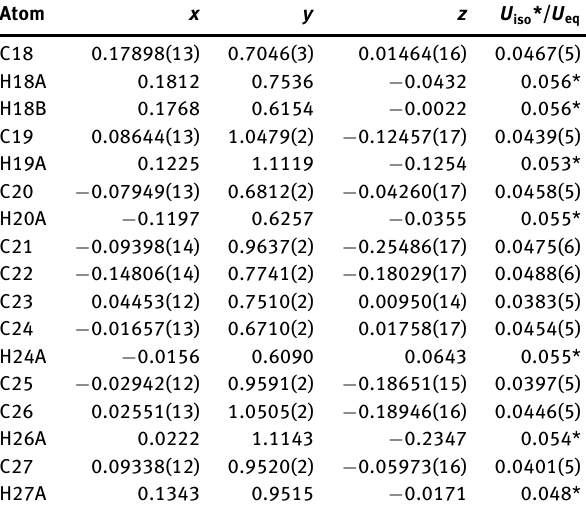
Table 2: Fractional atomic coordinates and isotropic or equivalent isotropic displacement parameters (Å 2